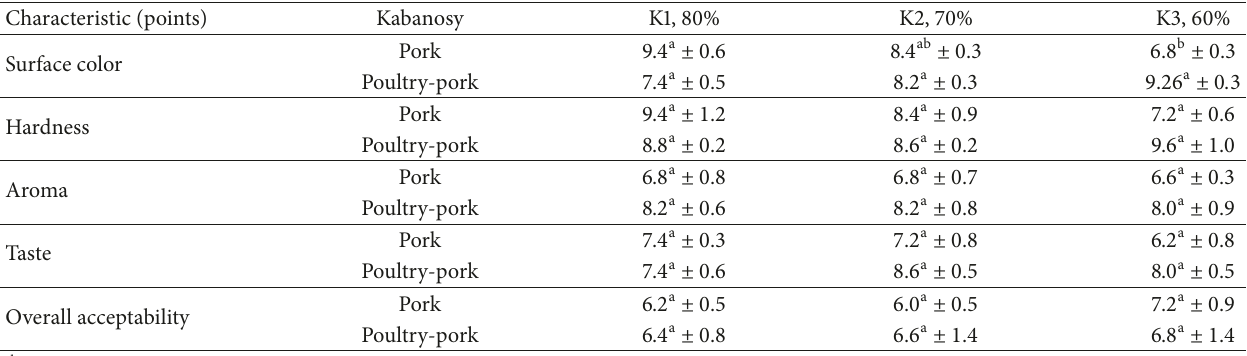
Table 4: The effect of air relative humidity on the sensory quality characteristics of